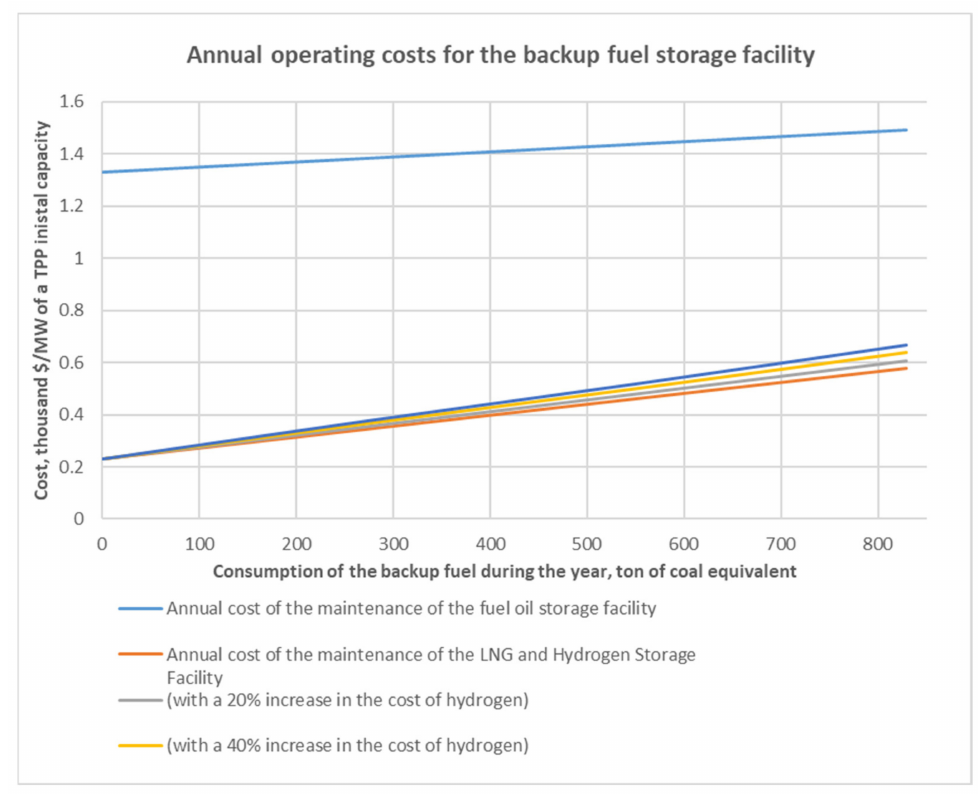
Figure 15. Annual operating costs for the backup fuel storage facility (the fuel oil storage facility and the LNG and liquid hydrogen storage